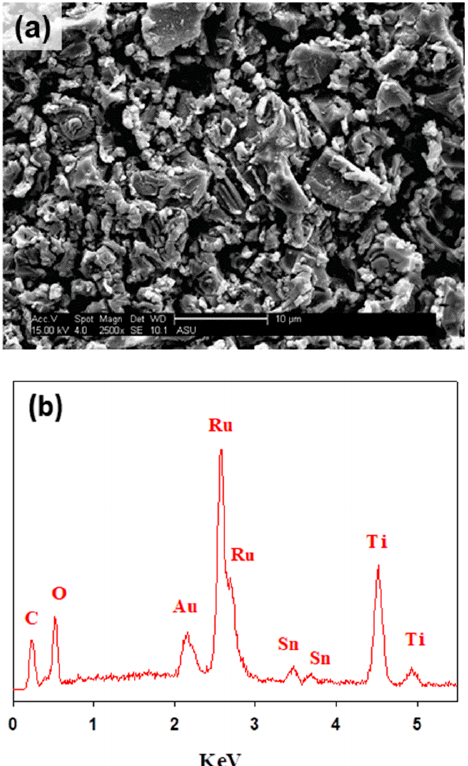
Figure 2. ( a ) SEM image of the DSA Ti/RuO 2 -TiO 2 -SnO 2 (50:40:10 atom. %) and ( b ) EDS